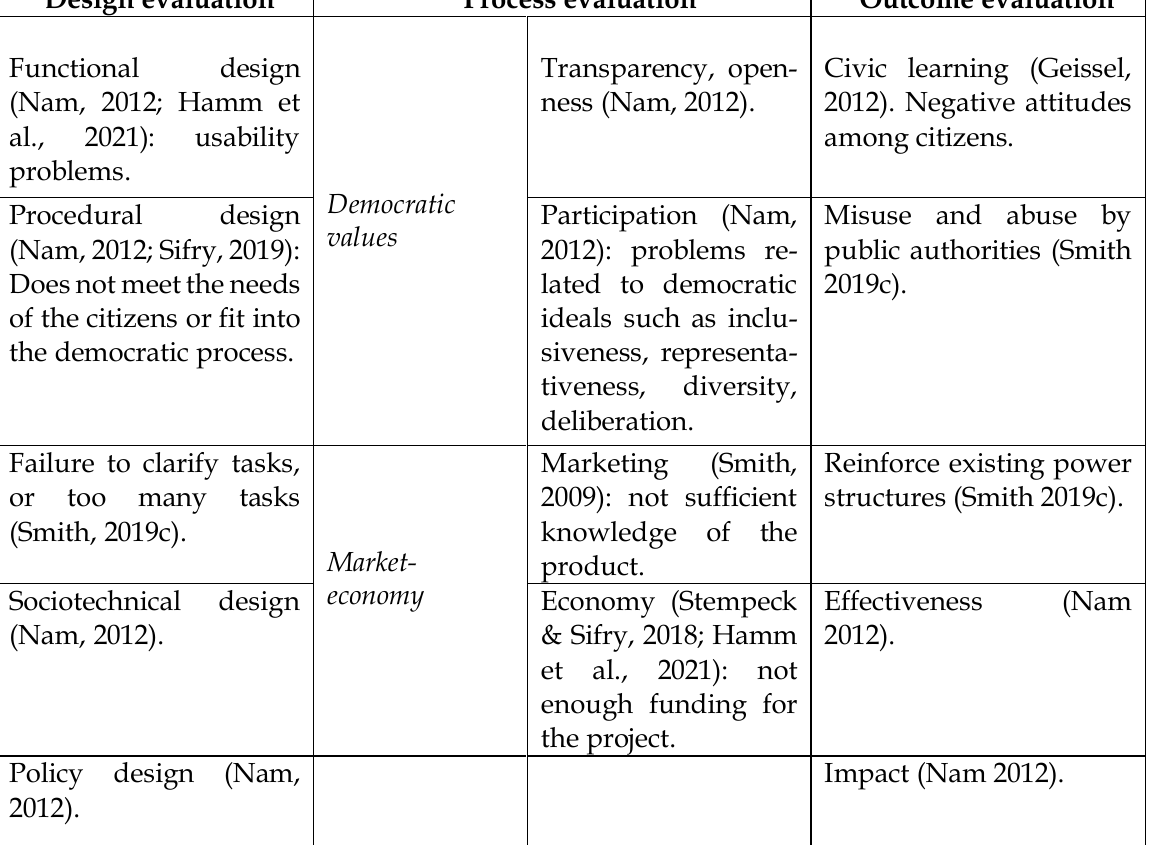
Table 1. Evaluating digital democratic